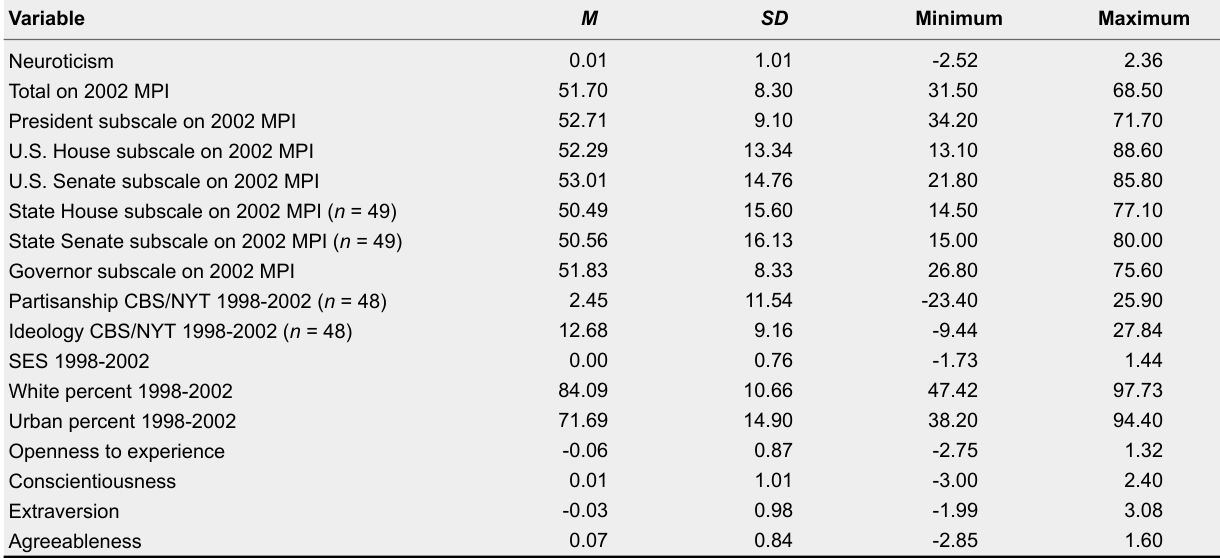
Descriptive Statistics for the 17 State Variables (N =